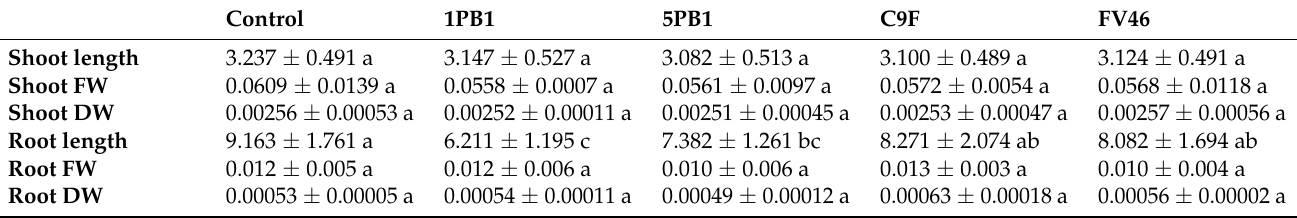
Table 1. Shoot and root length (cm), and weight (g) of 12 days-old seedlings under control conditions and inoculated with 1PB1, 5PB1, C9F, FV46 isolates. Values are means ± SD (n = 20) of measurements on each treatment. Means with the same letter are not significantly different according to the Dunnett test ( p < 0.05). FW—fresh weight; DW—dry